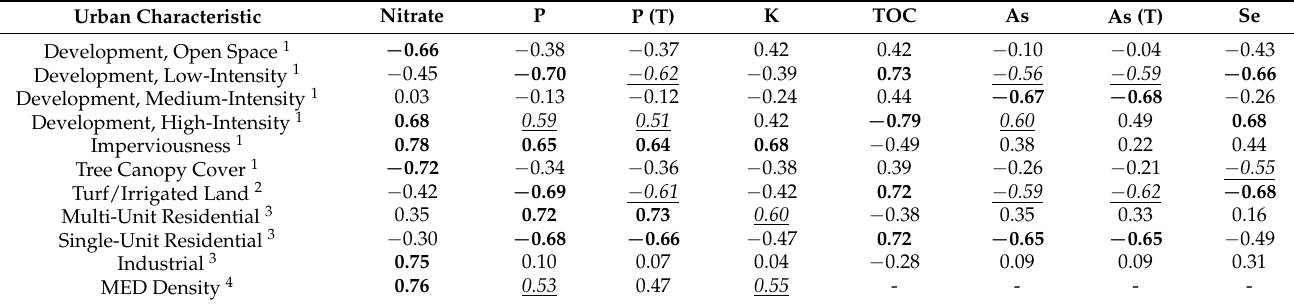
Table 8. Spearman’s rho correlations between mean pollutant concentrations and urban characteristics. Urban